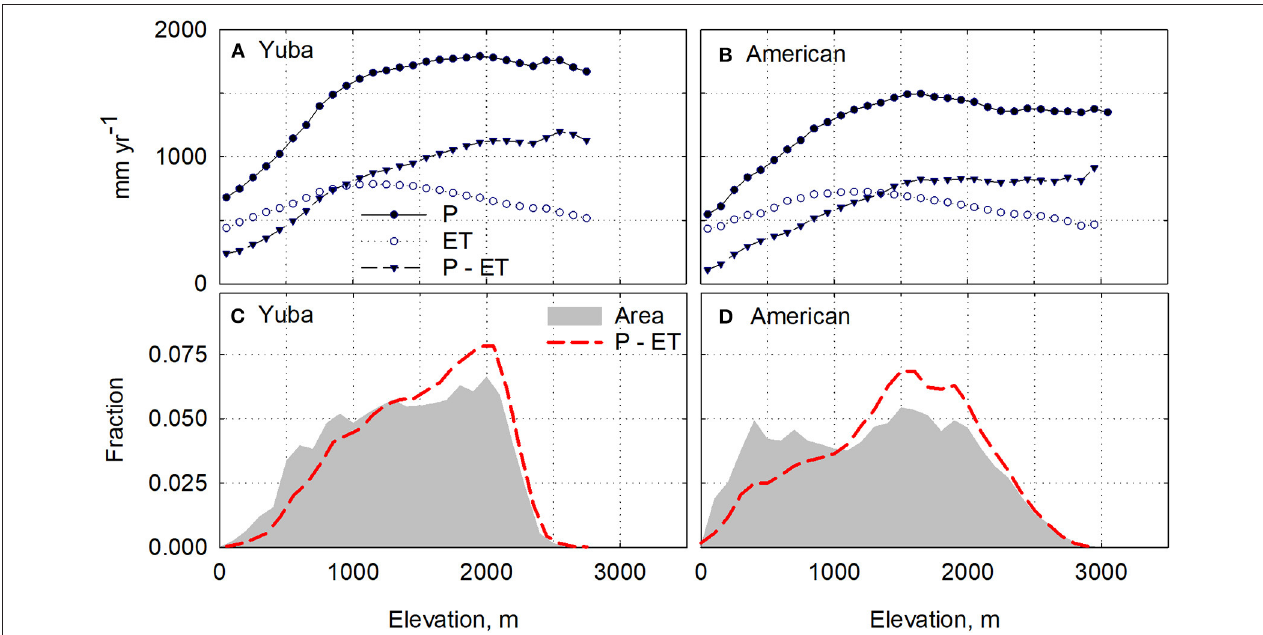
FIGURE 2 | Elevational distribution of mean precipitation ( P ) and evapotranspiration (ET), and P-ET in the (A) Yuba and (B) American River watersheds by 100-m elevation bin for the period 1985–2018. Basin-area fraction and volume fraction of P-ET in each 100-m band are shown on (C,D) . Volume fraction was calculated from depth and area fractions on (A,B) see Figure S5 for annual values for an average, wet, and dry